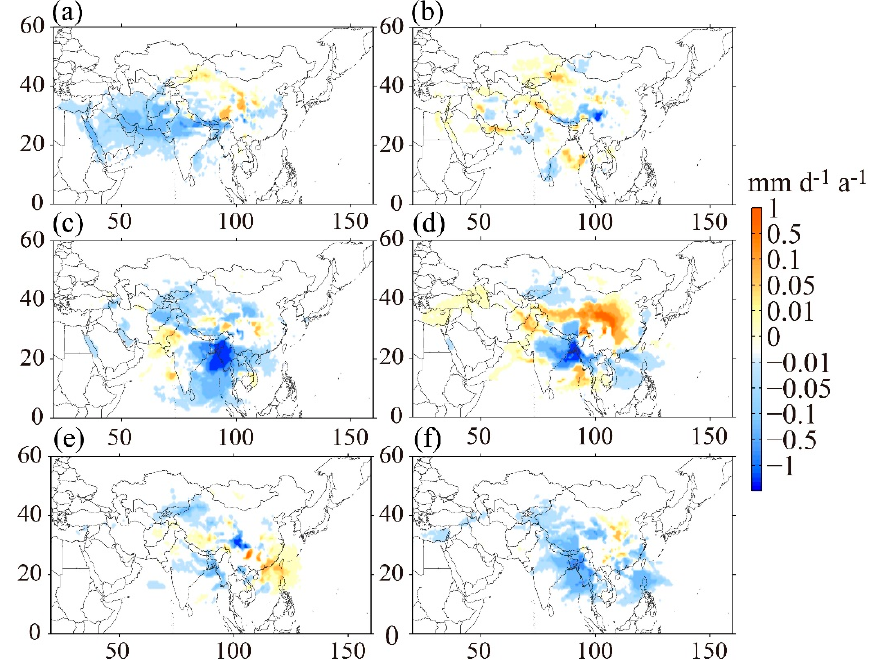
Figure 6. Linear trends of monthly common evaporative sources (unit: mm d − 1 a − 1 ) for the SETP and MYRB in the wet season ( a ) April, ( b ) May, ( c ) June, ( d ) July, ( e ) August, ( f ) September over 1982–2011. Common areas are defined as areas with the same positive or negative trends in terms of evaporative source for both target regions.